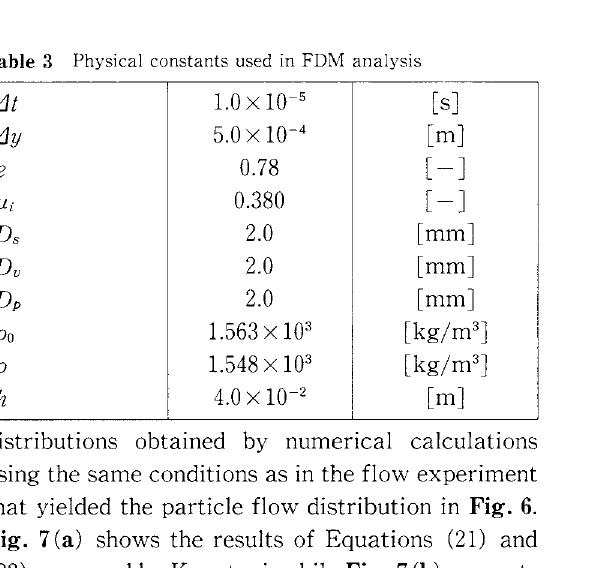
Boundary condition for calculation of velocity distribu titm of flowing particles on chute flow are as follows.